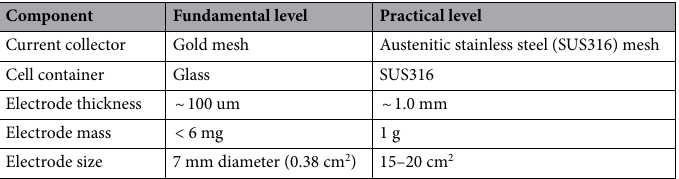
Table 1. Changes of the cell components from the fundamental research scale to the practical